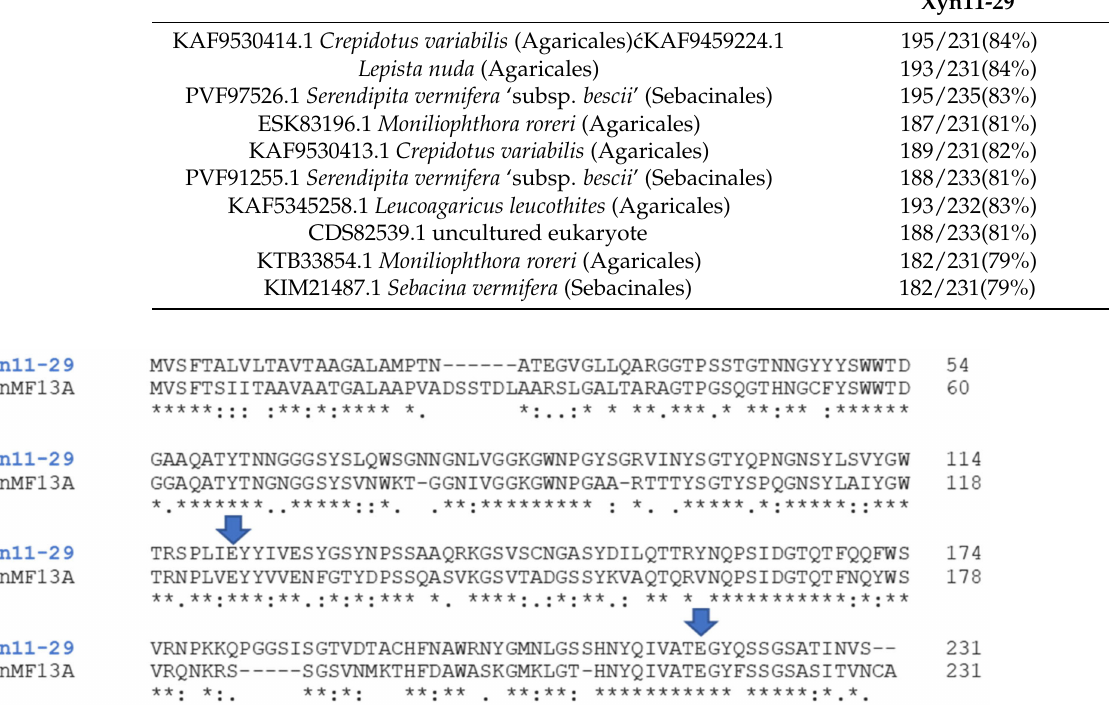
Figure 2. Sequence alignment of Xyn11-29 with the biochemically characterized xylanase XynMF13A isolated the mangrove fungus Phoma sp. (GenBank accession number AVV62005.1). The highly conserved glutamate catalytic residues are marked with blue arrows. Alignment was produced with Clustal Omega, and symbols below the sequences indicate full conservation of the same (asterisk) or equivalent residues (colon) and partial residue conservation